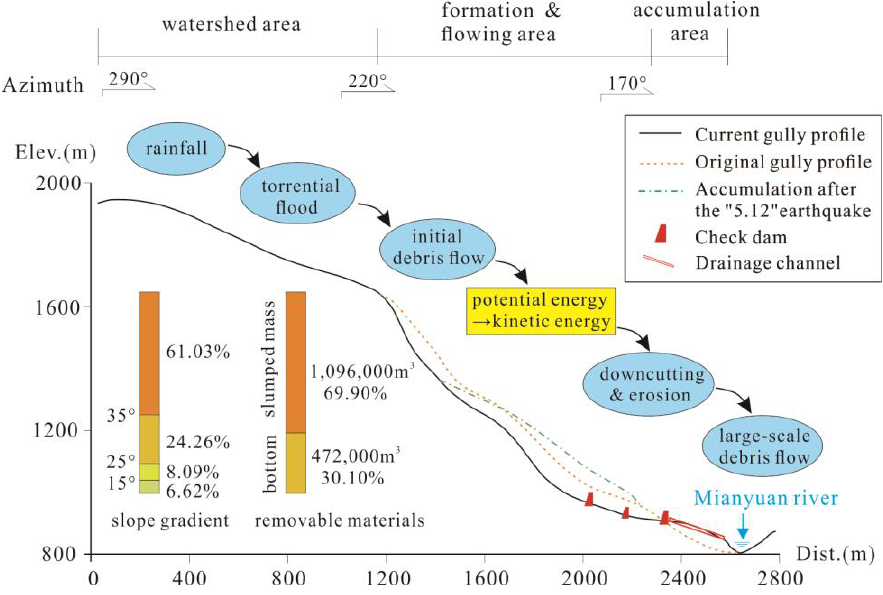
Figure 5. Source of debris flow kinetics in narrow-steep gullies.